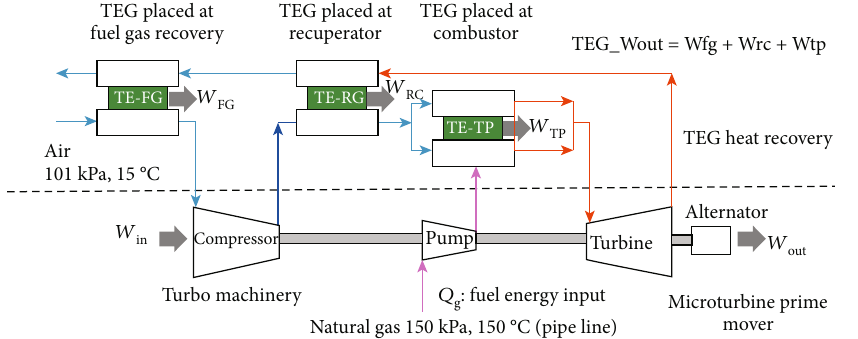
Figure 5: TEG and microturbine cogeneration (adapted from [7]).